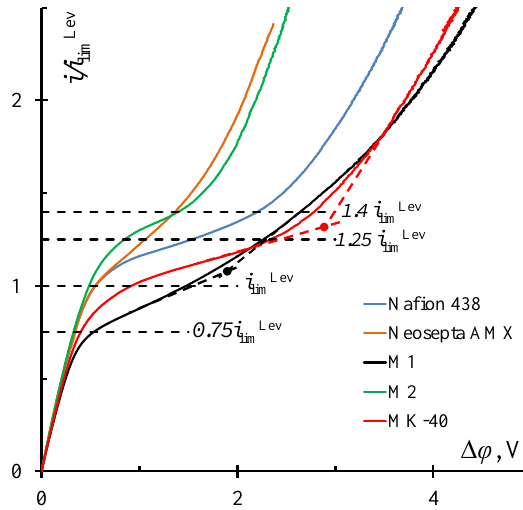
Figure 5. Current–voltage curves of the studied membranes in a 0.02 M NaCl solution at a linear flow velocity of 3.6 mm / s. Tangents and their intersection points show the right-hand edge of the limiting current plateau for M1 and MK-40 membranes